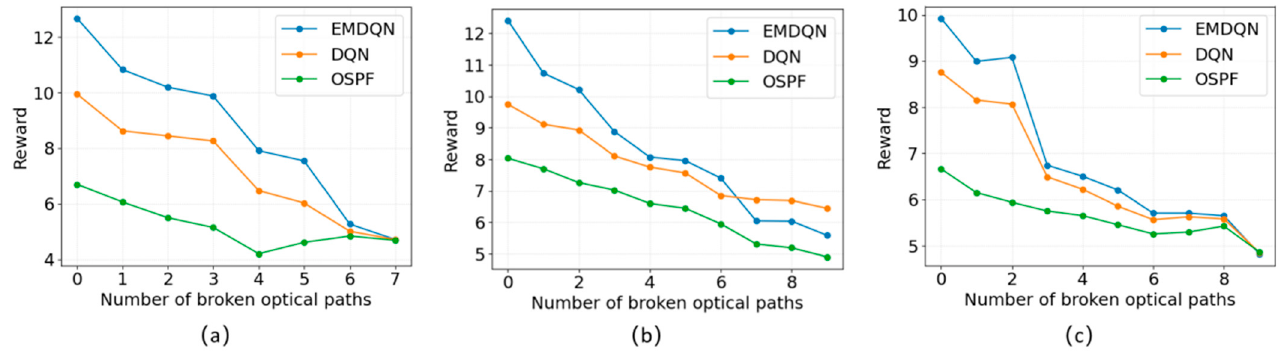
Figure 7. Evaluation of the model in different network scenarios with randomly broken lightpaths: ( a ) broken lightpath at NSFNET; ( b ) broken lightpath at GEANT2; ( c ) broken lightpath at GBN.